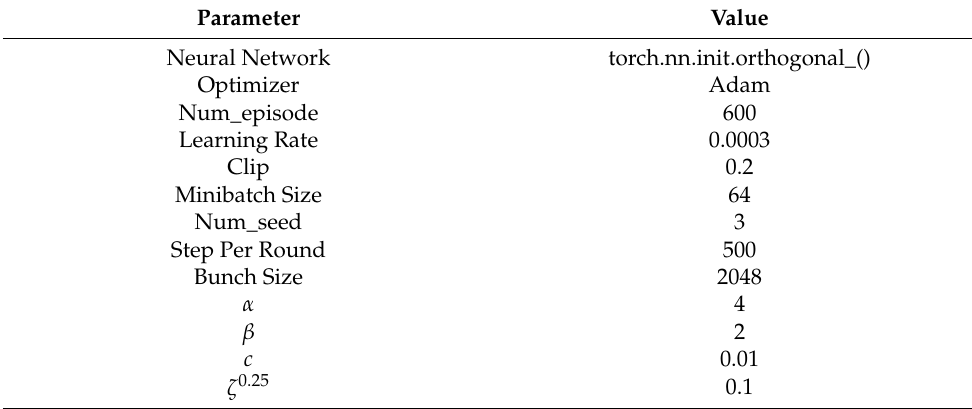
Table 1. Hyperparameter